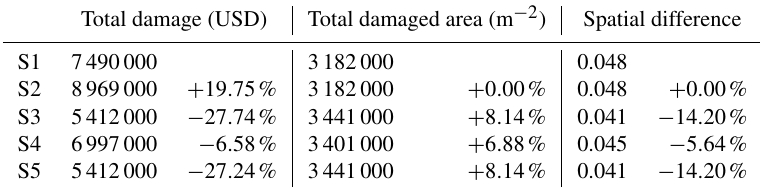
Table 5. Calculated total damage, total damaged area and spatial difference for S2, S3, S4 and S5 in comparison to S1. Total damage (USD)